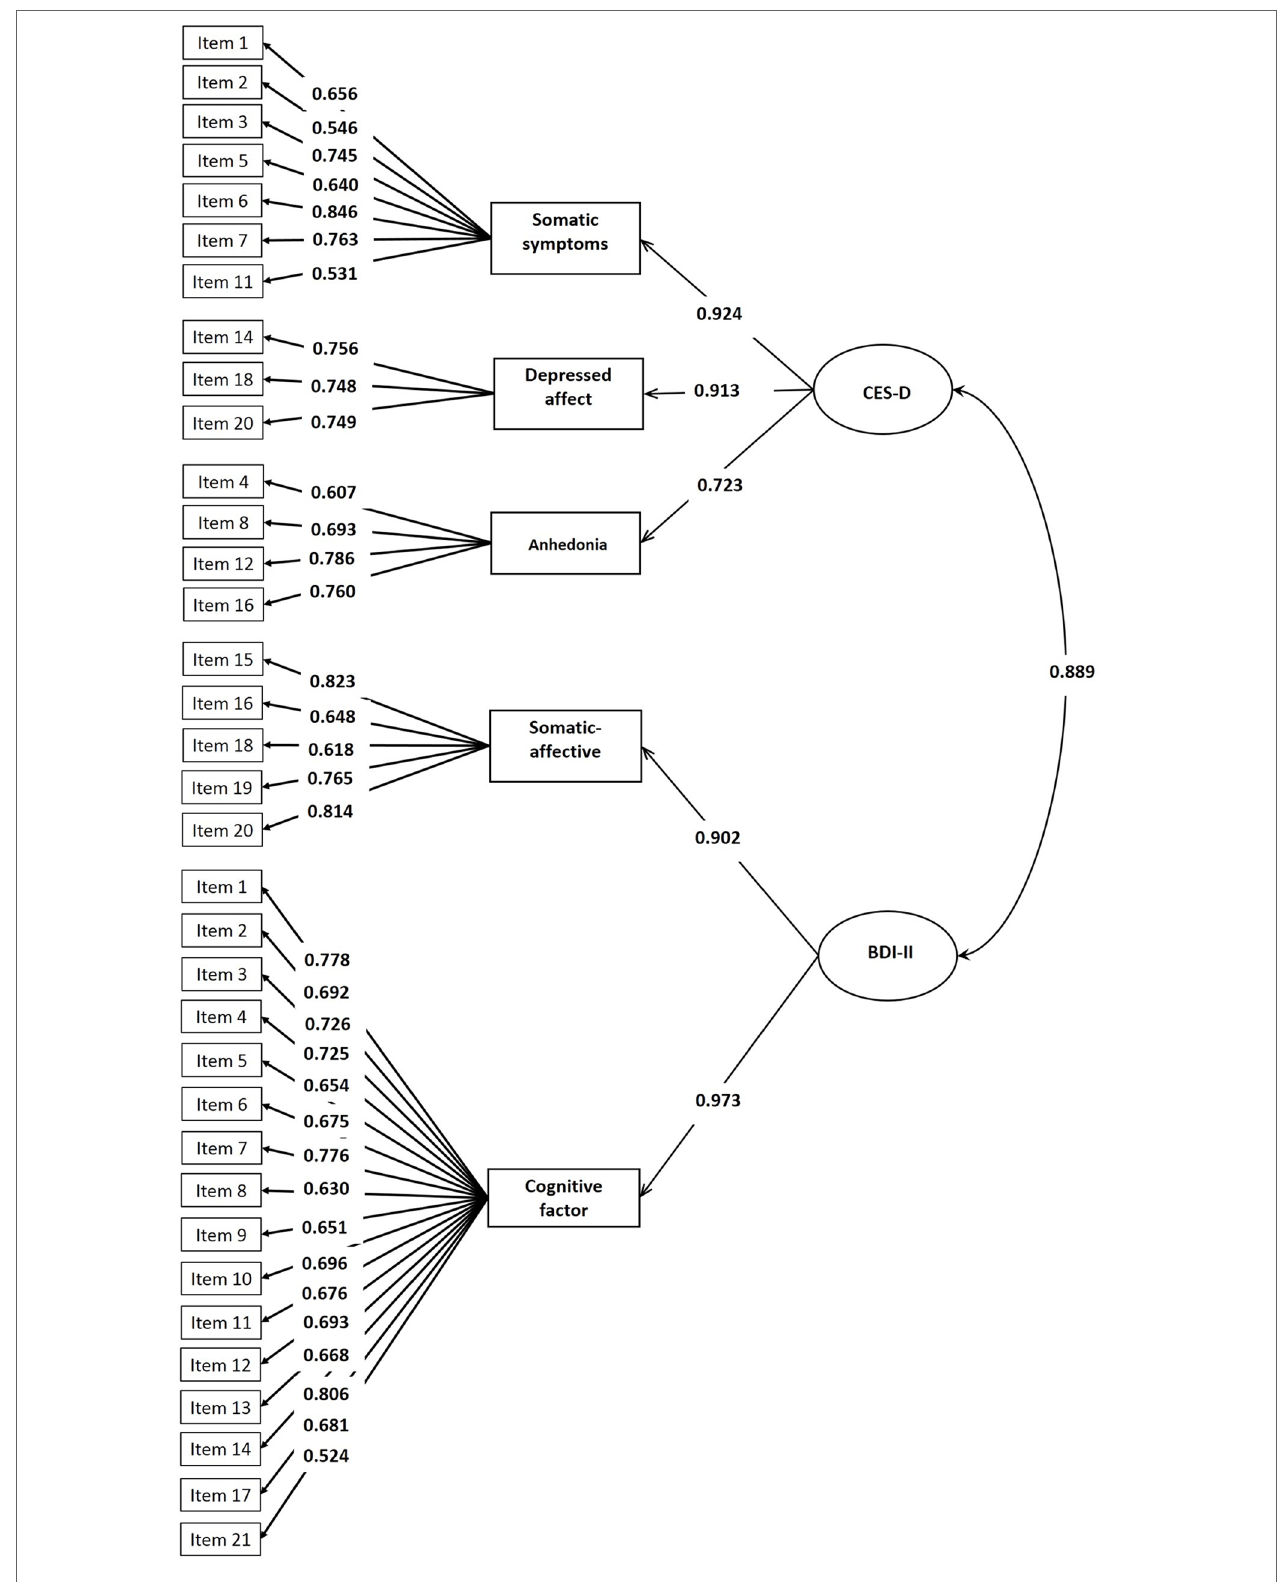
FIGURE 3 | Measurement model for the subscales of CES-D and